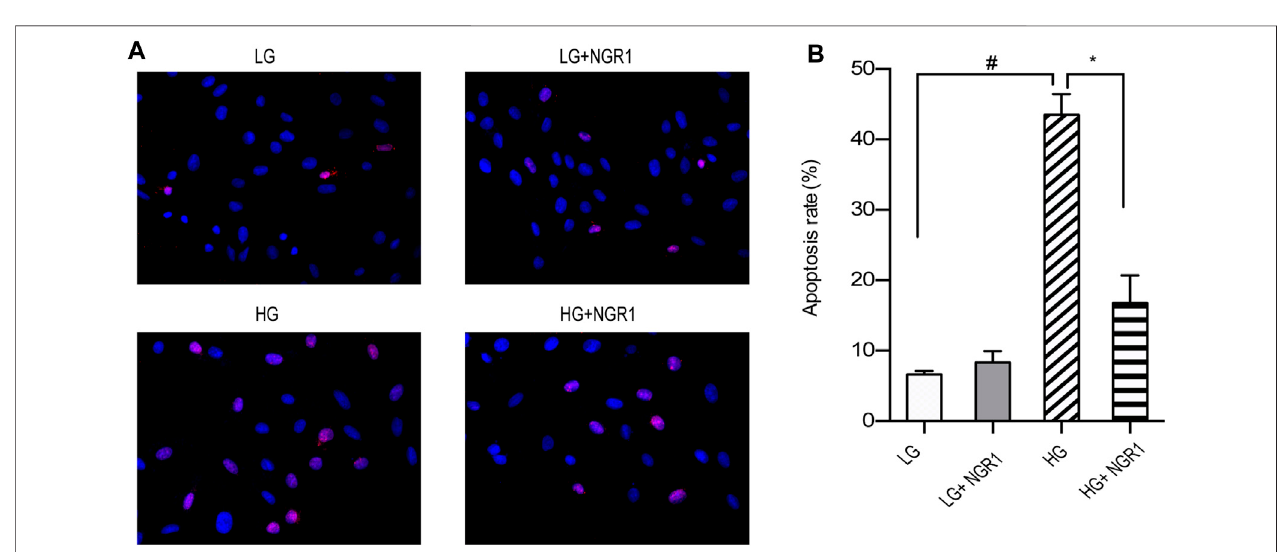
FIGURE 2 | NGR1 attenuates H9c2 cardiomyocyte apoptosis induced by high glucose concentration. (A) TUNEL staining at × 400 magni fi cation. High glucose concentration increased H9c2 cardiomyocyte apoptosis, but the effect was reduced by NGR1. (B) Pretreatment with NGR1 signi fi cantly reduced the apoptosis rate. Data are shown as the means ± SEM of three independent experiments, * p < 0.001 and # p < 0.001. LG, 5.5 mM glucose; HG, 30 mM glucose; NGR1, Notoginsenoside R1.